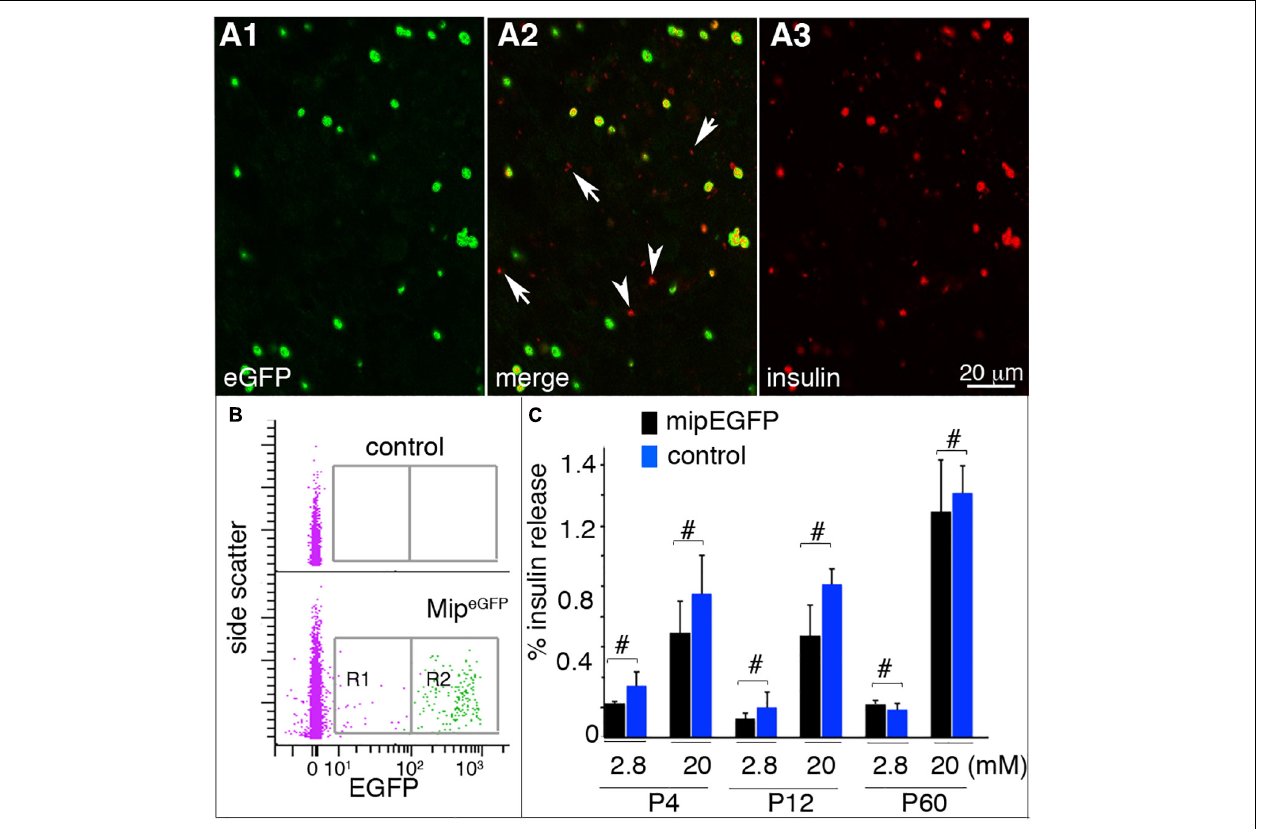
FIGURE 1 | Mip eGFP islets maintain glucose responsiveness. Hand-picked, dissociated or intact, islets were used for these assays. (A) Immunostaining of P4 Mip eGFP islet cells. Arrowheads: insulin + cell with undetectable EGFP. Arrows: debris (judged by size) picking up secondary antibodies. (B) EGFP analysis in P4 Mip eGFP islet cells via flow cytometry. R1 and R2 are the EGFP Lo and EGFP Hi cells collected for RNA-seq. (C) GSIS of islets from Mip eGFP mice and wild-type littermates at P4, P12, and P60. Shown are the percentages of total insulin from starting islets released in 30 min. # p ≥ 0.1, Wilcoxon rank-sum test ( n = 5,